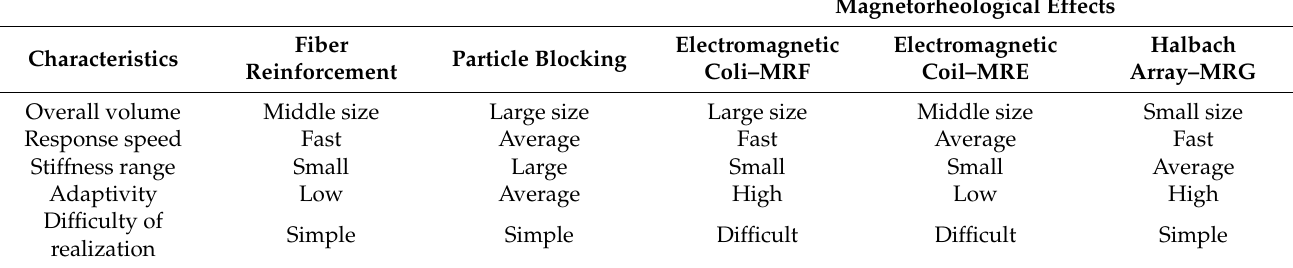
Table 1. Comparison of variable stiffness